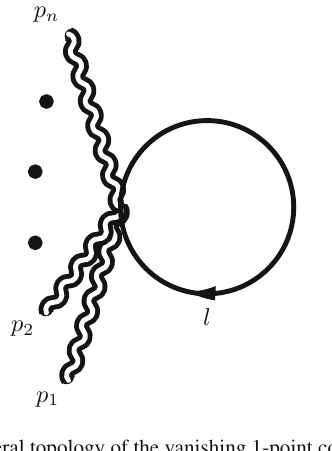
Fig. 1 The general topology of the vanishing 1-point contributions